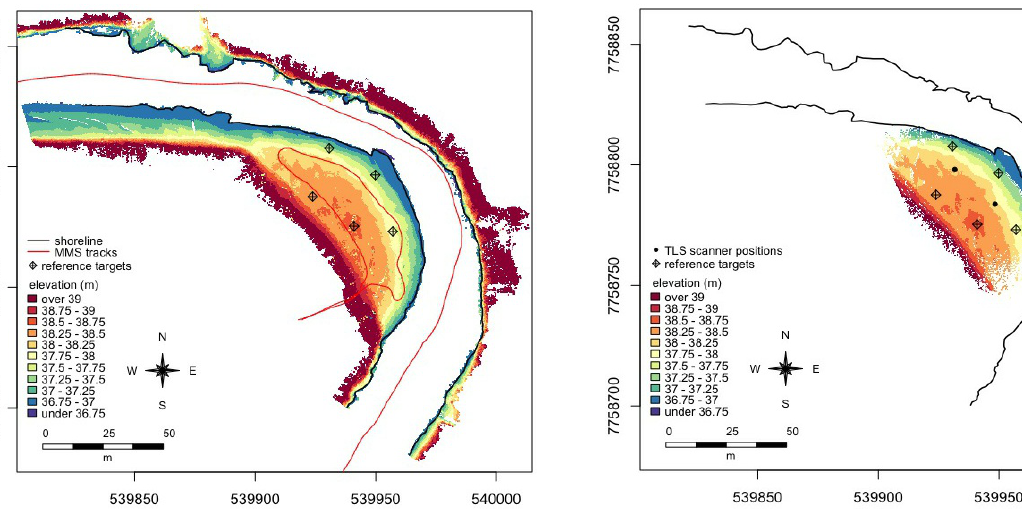
Figure 2. Moble LiDAR point cloud of 2010 ( left ) and TLS reference point cloud 2010 ( right ) coloured by